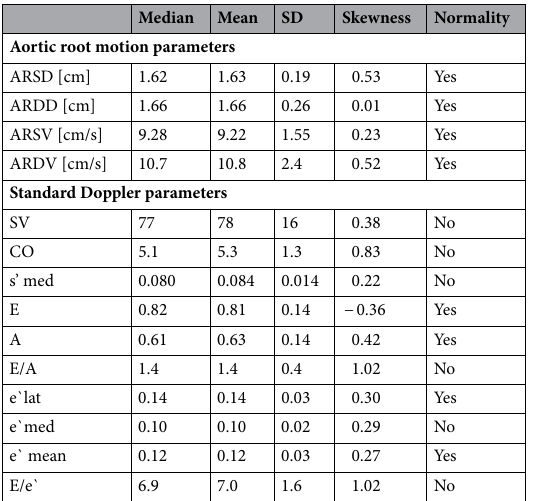
Table 2. Basic statistics of the aortic root parameters and standard Doppler parameters. ARSD aortic root systolic distance, ARDD aortic root diastolic distance, ARSV aortic root maximal systolic velocity, ARDV aortic root maximal diastolic velocity, SV stroke volume, CO cardiac output, s ′ med peak systolic velocity of medial mitral annulus by tissue Doppler, E transmitral E wave velocity, A transmitral A wave velocity, E/A ratio of the transmitral E wave velocity and A wave velocity, e ′ lat tissue Doppler lateral e ′ wave velocity, e ′ med tissue Doppler medial e ′ wave velocity, e ′ mean tissue Doppler mean e ′ wave velocity, E/e ′ ratio of transmitral E wave velocity to mean tissue Doppler e ′ wave velocity.